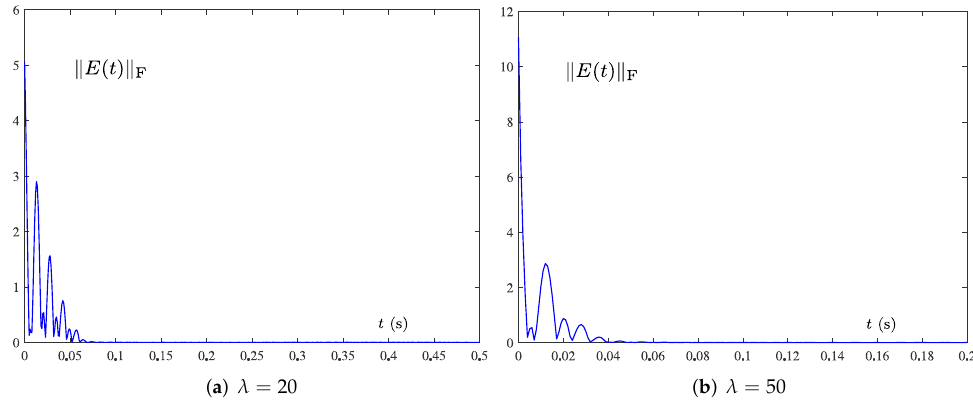
Figure 6. Simulation results by the PTCAZNN model (15) with λ = 20,50 for TVMIP of (40) under the same single-harmonic noise when f = 50